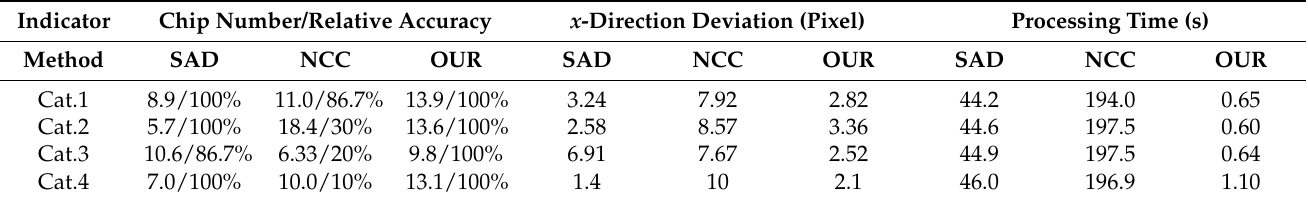
Table 6. Comparison of the number and accuracy of matching chips, x -direction deviation, and processing time of SAD, NCC, and the proposed